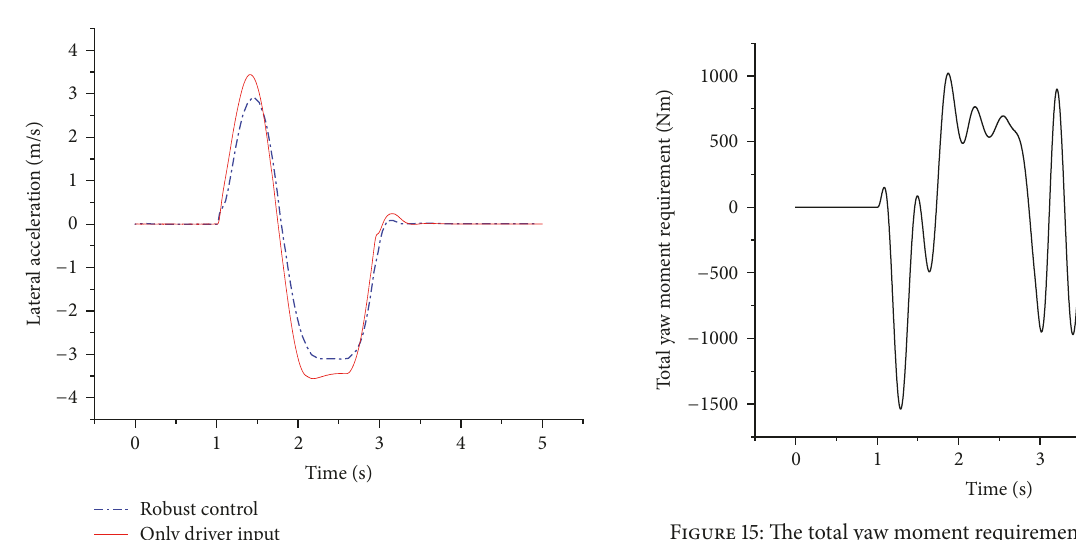
Figure 12: Sideslip angle in mass center comparison.